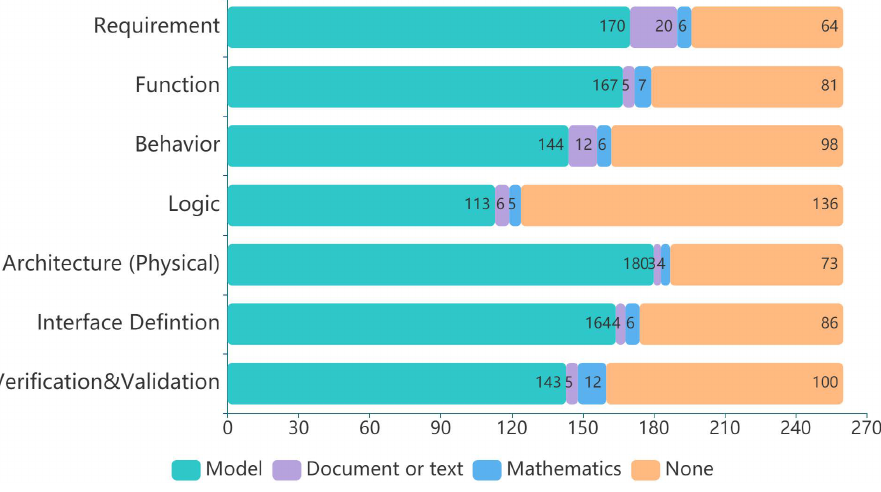
Figure 8. Formalisms mentioned in the studies.